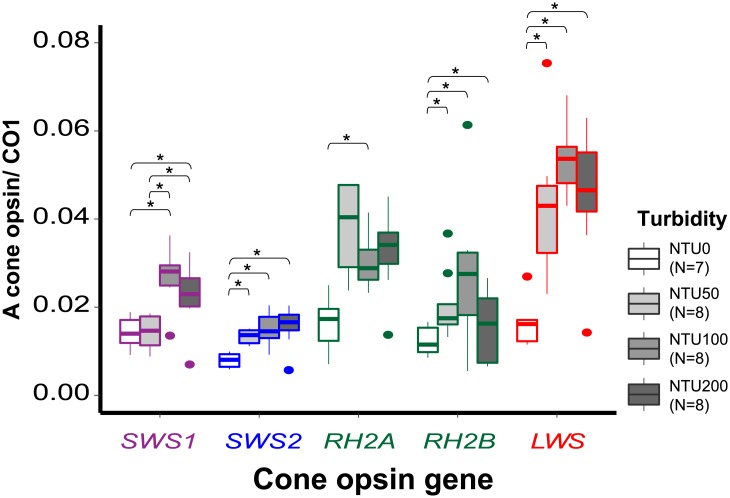
Box plot showing the median (—), 25th and 75th percentiles (box), 95% range (|), and outliers (•) of cone opsin relative expression values for different turbidity treatments.An asterisk indicates P < 0.05 (one-way ANOVA, post hoc Tukey’s comparisons). The box color of each opsin family represents its general λmax range. SWS1’s is ultraviolet light, SWS2’s is blue light, RH2’s is green light, and LWS’s is red light.